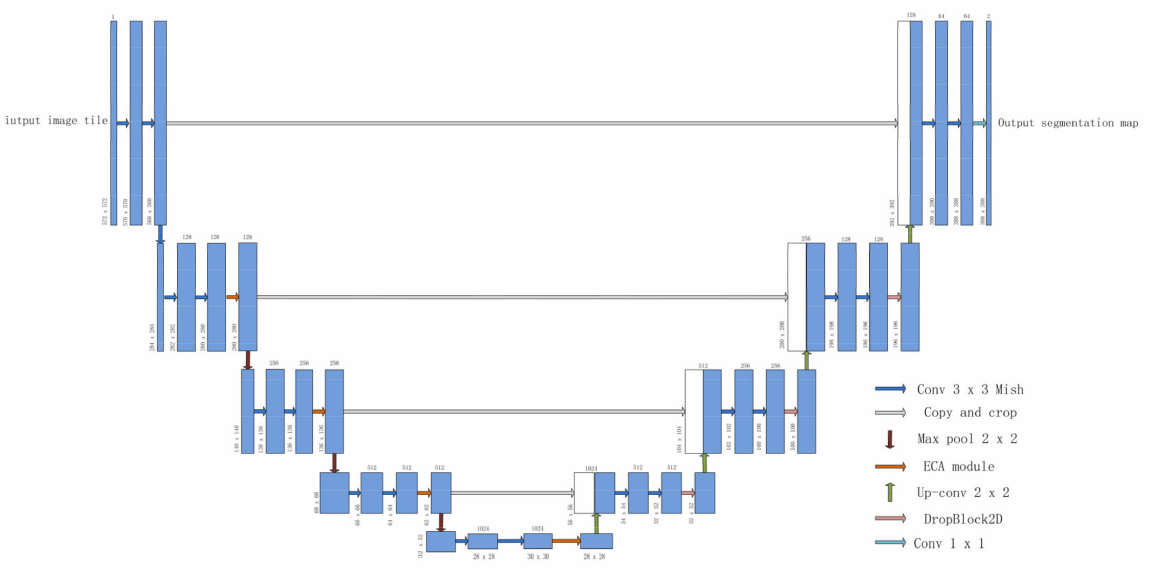
Figure 6. Semantic segmentation models.